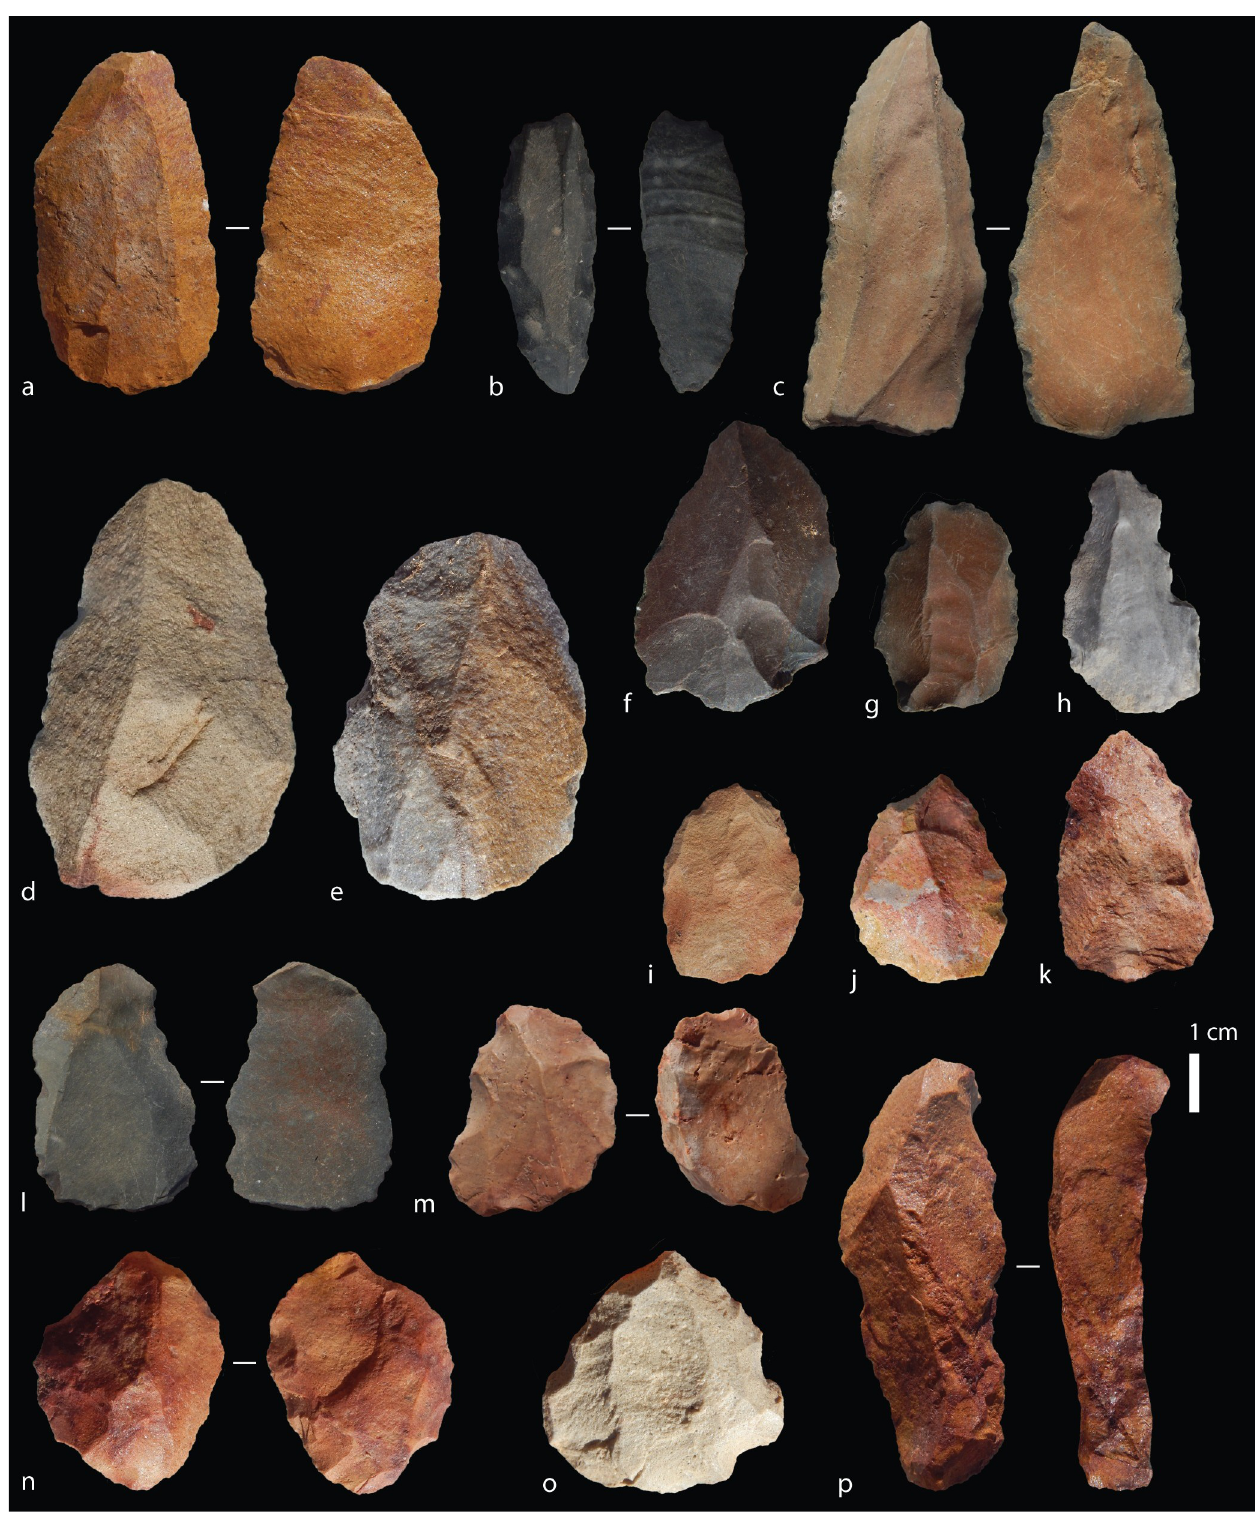
Fig 15. KOB20 artefacts. (a-k) Points, (l, p) overshot flakes from Nubian cores, (m, n) reworked Nubian core fragments, (o) Nubian Type 2 core. Raw material: (a, d, i-k, m-p), silcrete, (b-c, f-g, l) hornfels, (e) quartzite, (h) CCS.